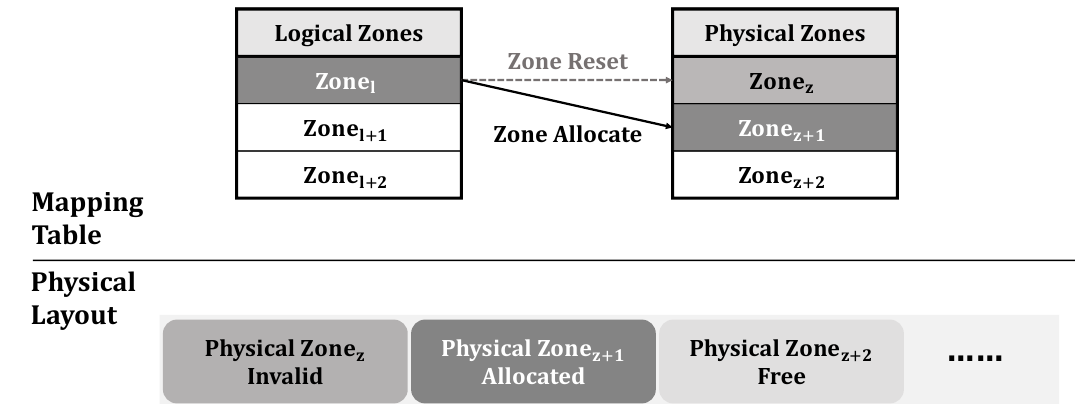
Figure 1. Logical-to-Physical Zone Mapping Method.